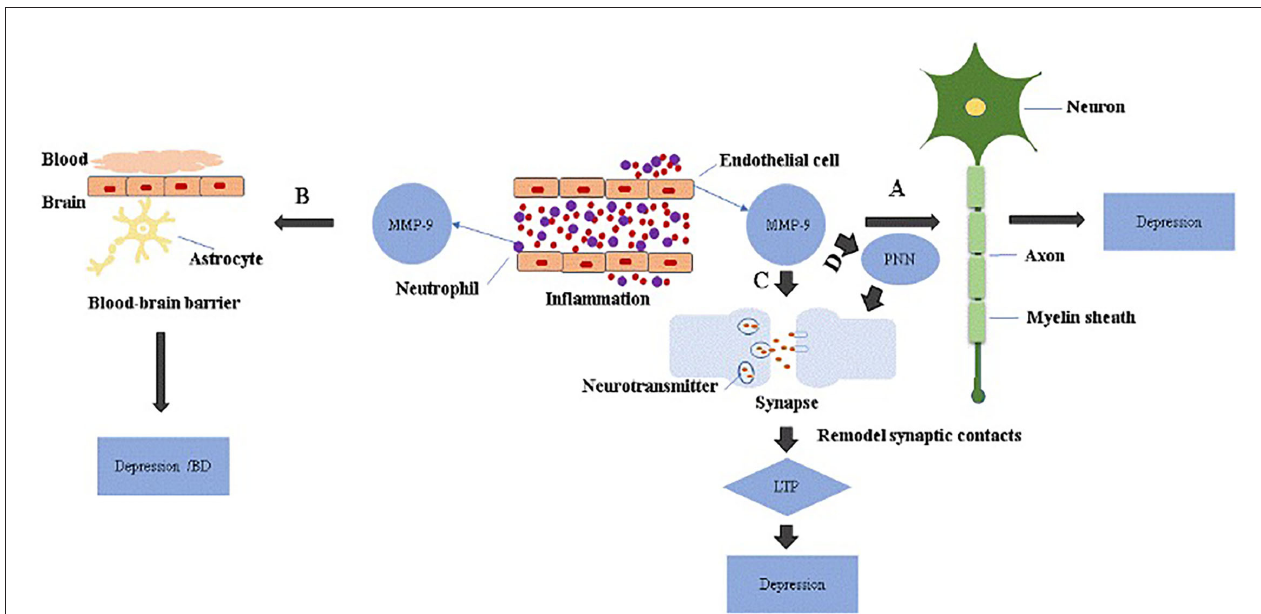
FIGURE 1 | The role of MMP-9 in the pathology of depression. MMP-9 is elevated in endothelial cells and neutrophils during inflammation. (A) Excessive MMP-9 is thought to be involved in demyelination associated with depression. (B) MMP-9 disrupts BBB through tight junction proteins or basement membrane degradation, which increases neuroinflammation and may be linked to depression or bipolar disorders with cognitive decline. (C) Activated MMP-9 localizes in part to synapses and is involved in synaptic pruning essential for longterm potentiation (LTP), and attenuation of cortical synaptic LTP-like plasticity; collectively, these are thought to contribute to depression. (D) MMP-9 remodels perineuronal nets that participate in synaptic stabilization and limit synaptic plasticity. Depression may occur when perineuronal net signaling is